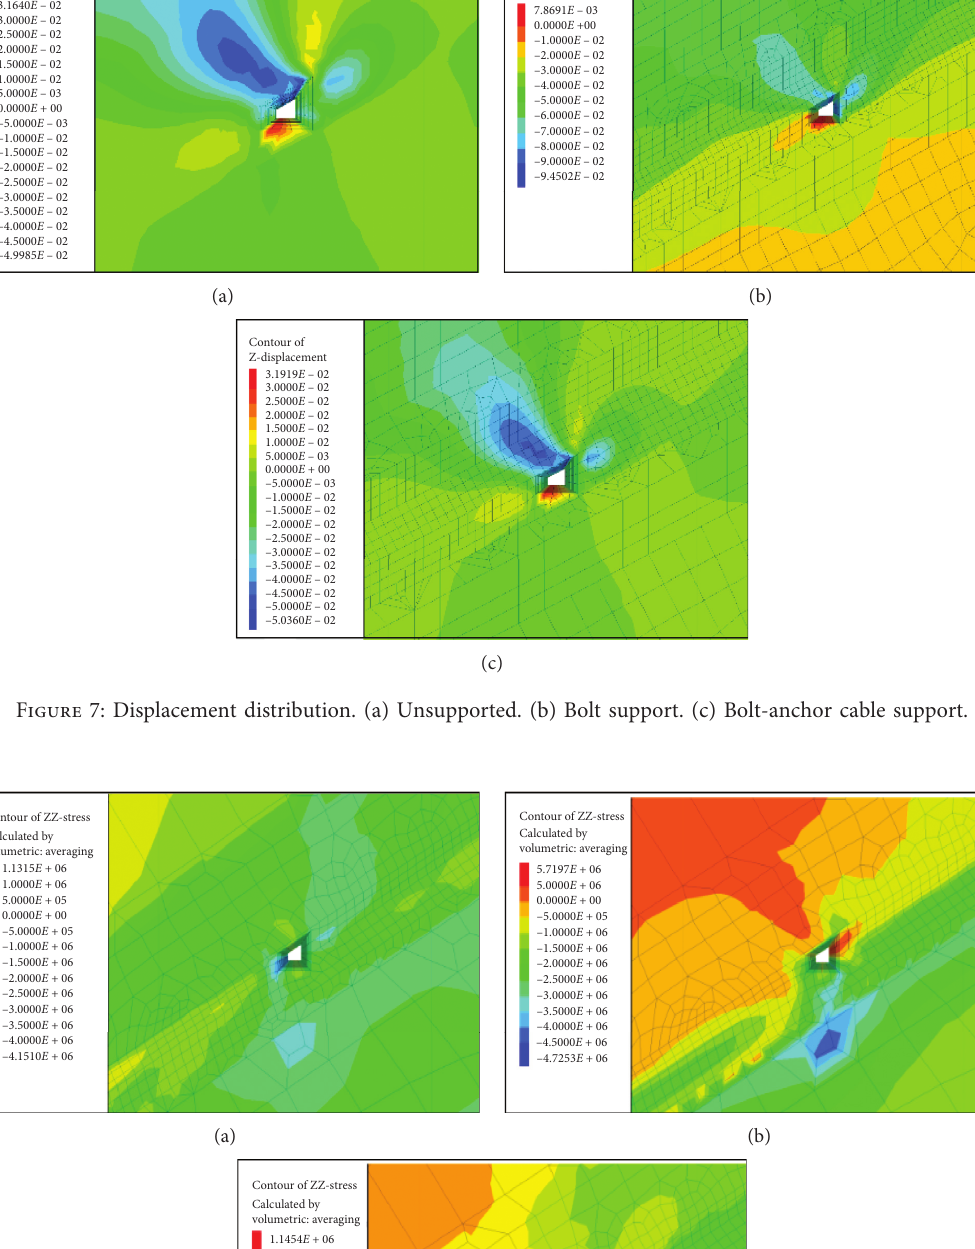
Figure 8: Stress distribution. (a) Scheme 1: interval 1.0m × 0.8m. (b) Scheme 2: interval 1.0 m × 1.0m. (c) Scheme 3: interval 1.0m ×